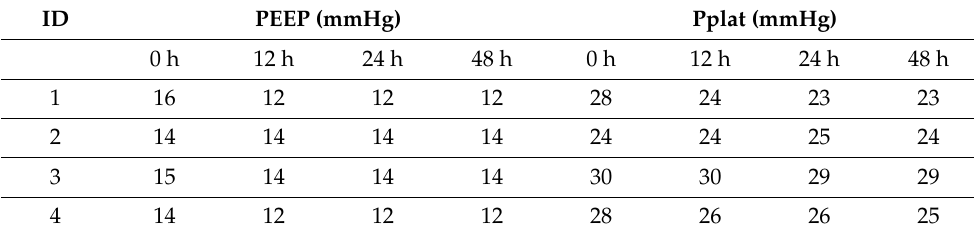
Table 4. Airway pressure values before (0 h), and 12, 24 and 48 h after, the segmental lung recruitment.